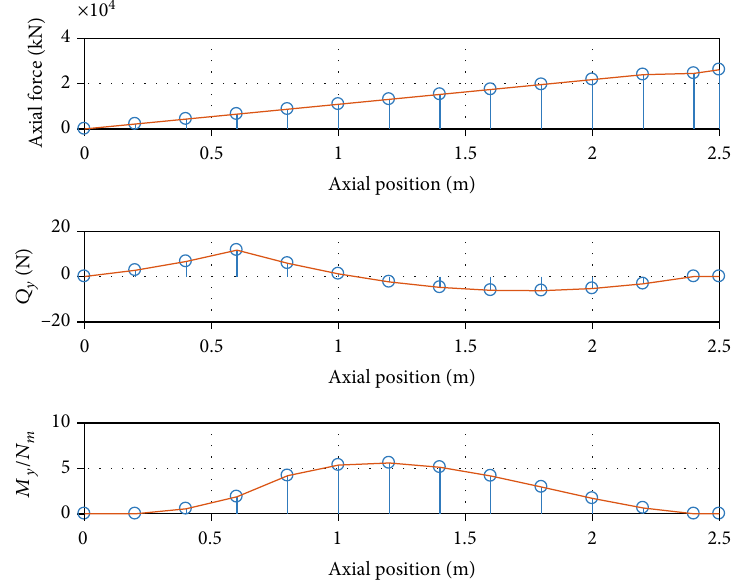
Figure 10: The axial force, shear force, and bending moment at 45s with improved